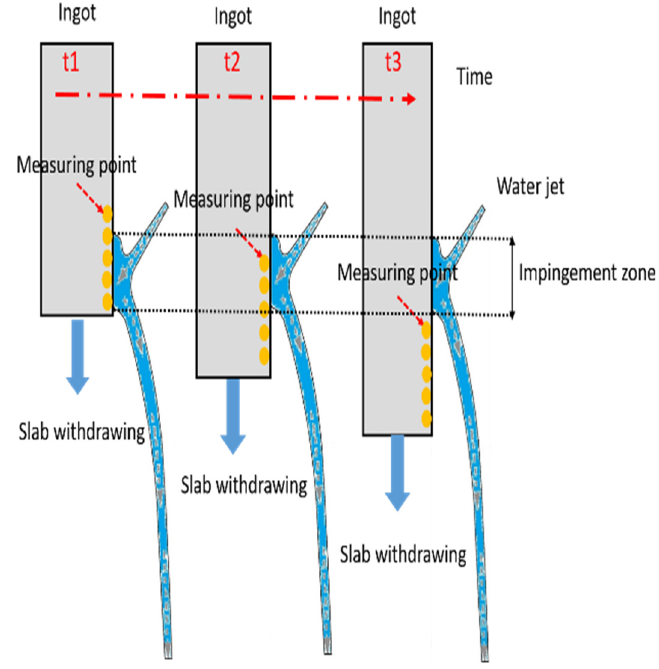
Figure 7. Graphic illustration determining the moment of thermocouples insertion into the melt and water impinging on the ingot surface.